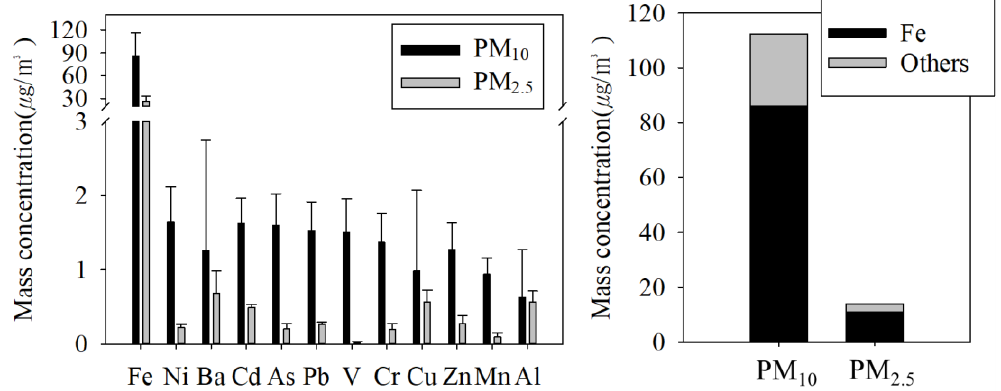
Figure 10. Mass concentrations of inorganic components in PM at the M station.